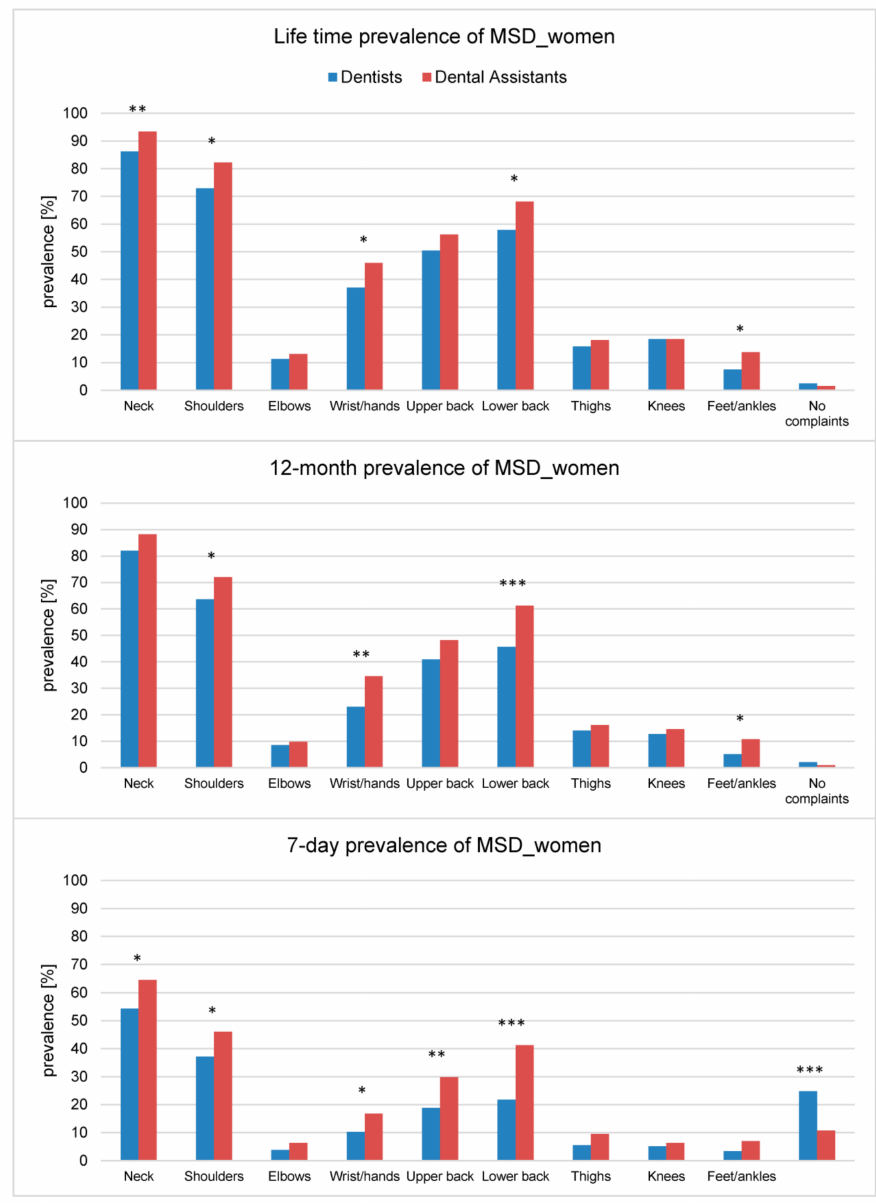
Figure 2. Lifetime prevalence, 12-month prevalence and 7-day prevalence of MSD among female dentists and dental assistants. Significant differences between dentists and dental assistants are marked with asterisks: p < 0.05 = *; p < 0.01 = **; p < 0.001 =